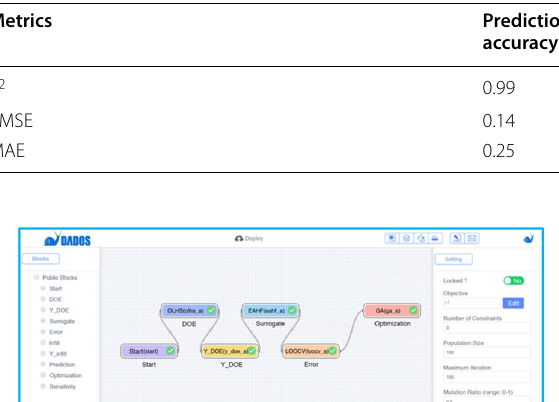
Table 1 The prediction accuracy of the E-AHF model for the